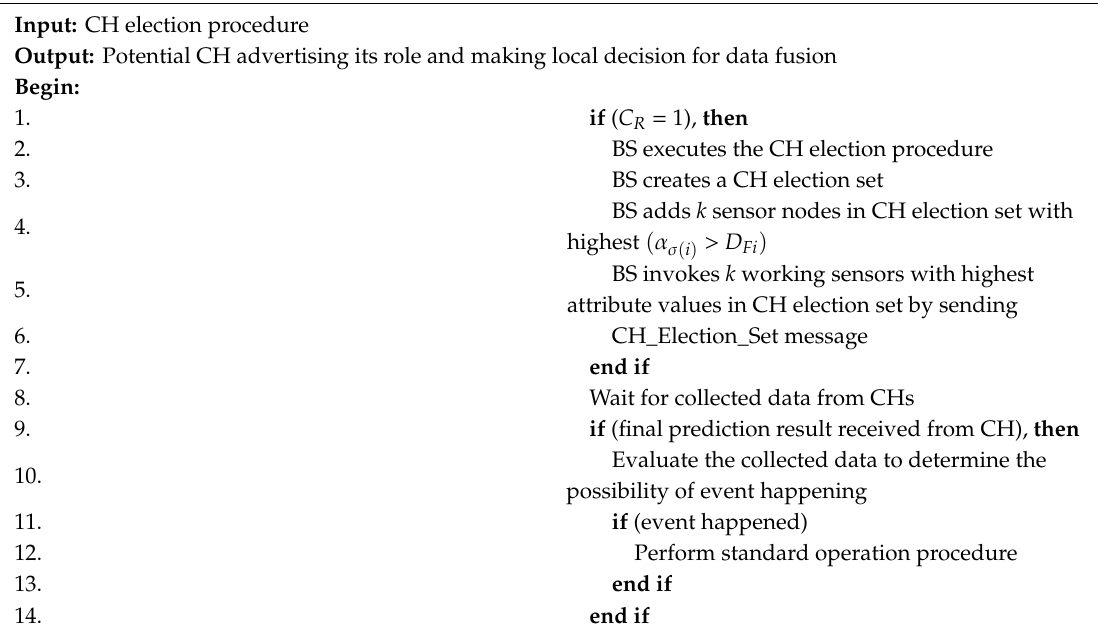
Algorithm 2. HFECS (BS